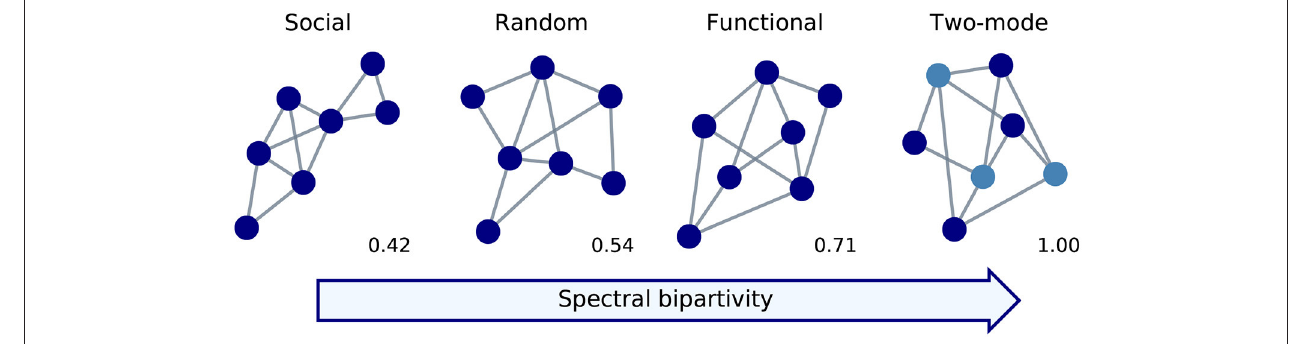
FIGURE 2 | Toy networks with seven nodes and eleven edges, each of a different type, shown in increasing order of their spectral bipartivity